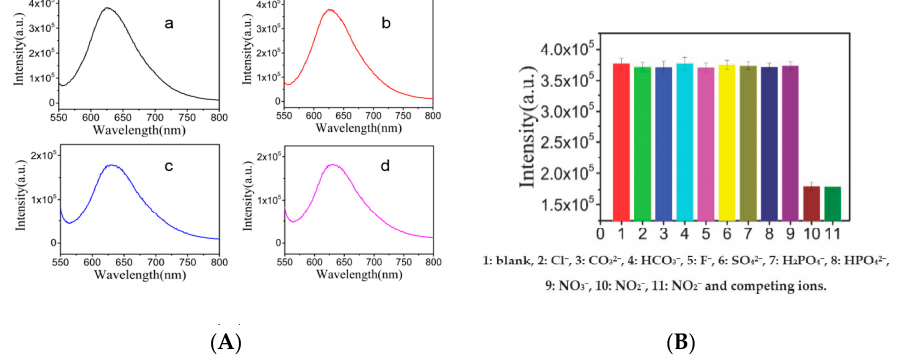
Figure 8. ( A ) Fluorescence spectra of the (a) NR- β -CD@AuNPs; (b) NR- β -CD@AuNPs and